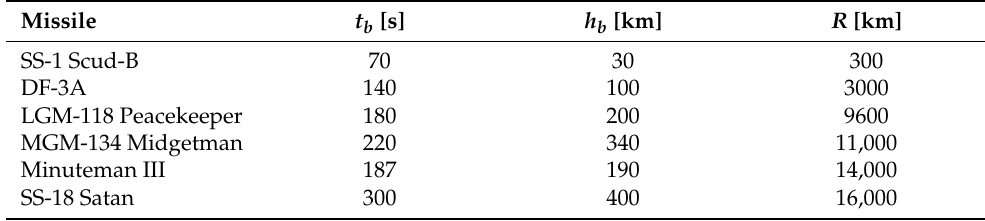
Table 2. Burning time ( t b ), burn-out altitude ( h b ) and max range ( R ) of various kind of missiles (from short to intercontinental range). Data from [9,11,18]. The max range depends on the payload. Since some missiles have been developed to carry various kinds and numbers of warheads, the stated max range is that corresponding to the minimum